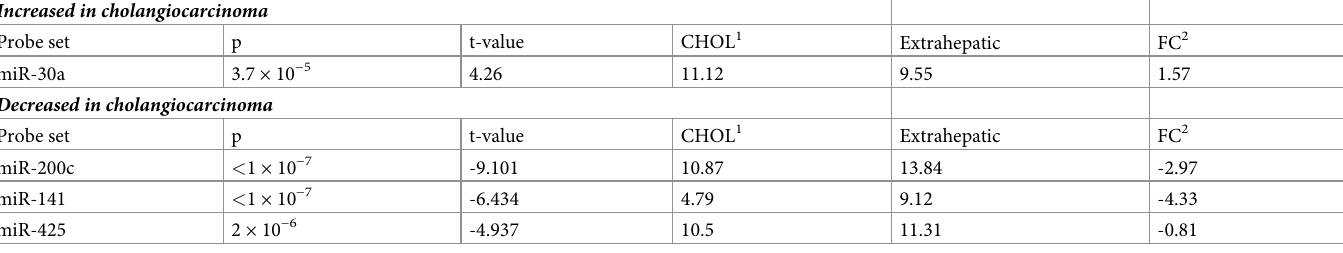
Table 2. The cholangiocarcinoma signature for the differential expression of microRNAs between intrahepatic cholangiocarcinomas and extrahepatic adenocarci- nomas originating from the colon, stomach, pancreas, lung, breast, uterus, and ovary, at p < 0.00005 (node no. 7 of the decision tree; miR-122 was omitted from the